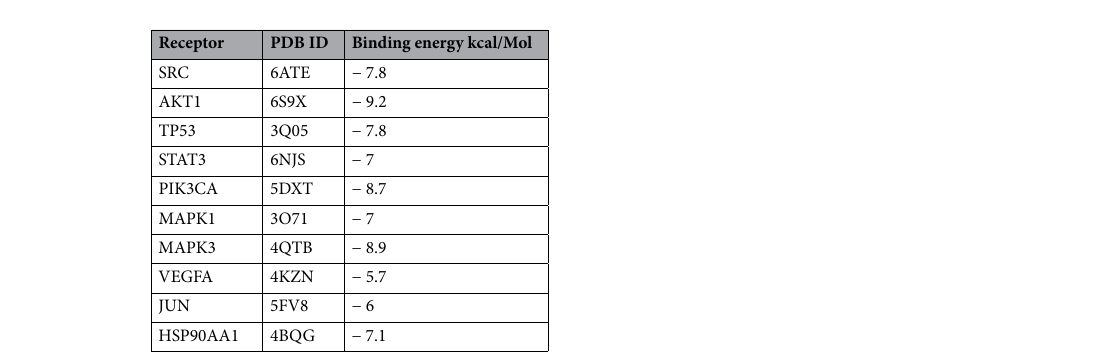
Table 3. Molecular docking scores of andrographolide and hub target proteins.